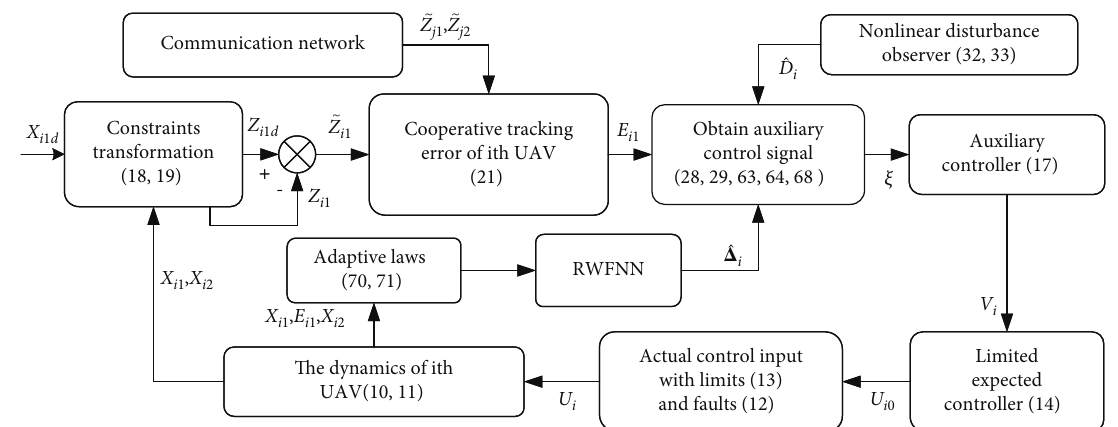
Figure 2: The proposed control scheme for the i th